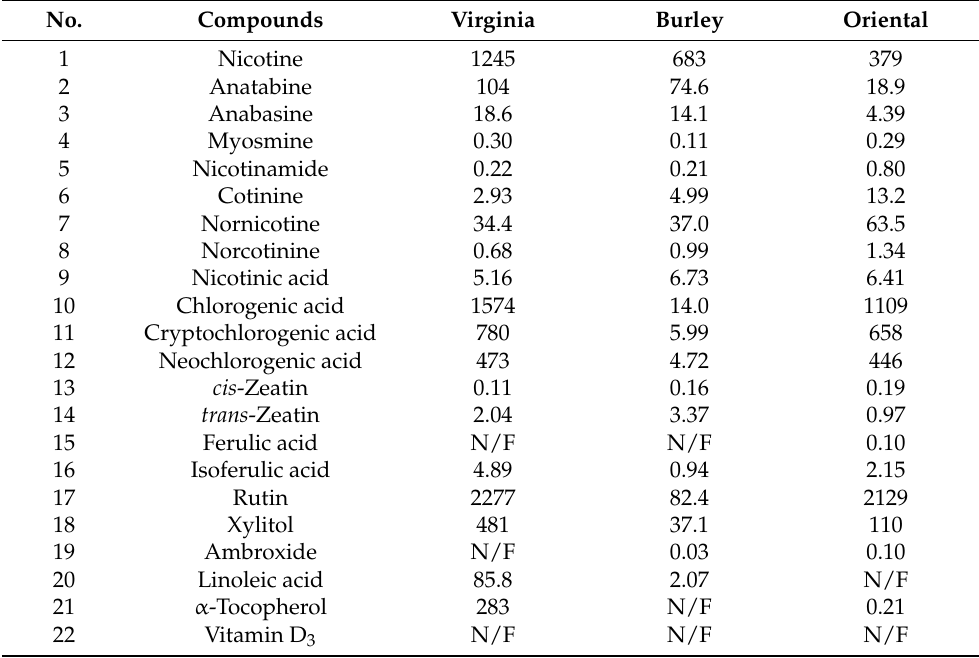
Table 2. Total determined contents of 22 reference compounds in the three varieties: Virginia, Burley, and Oriental ( µ g/g dry plant material).